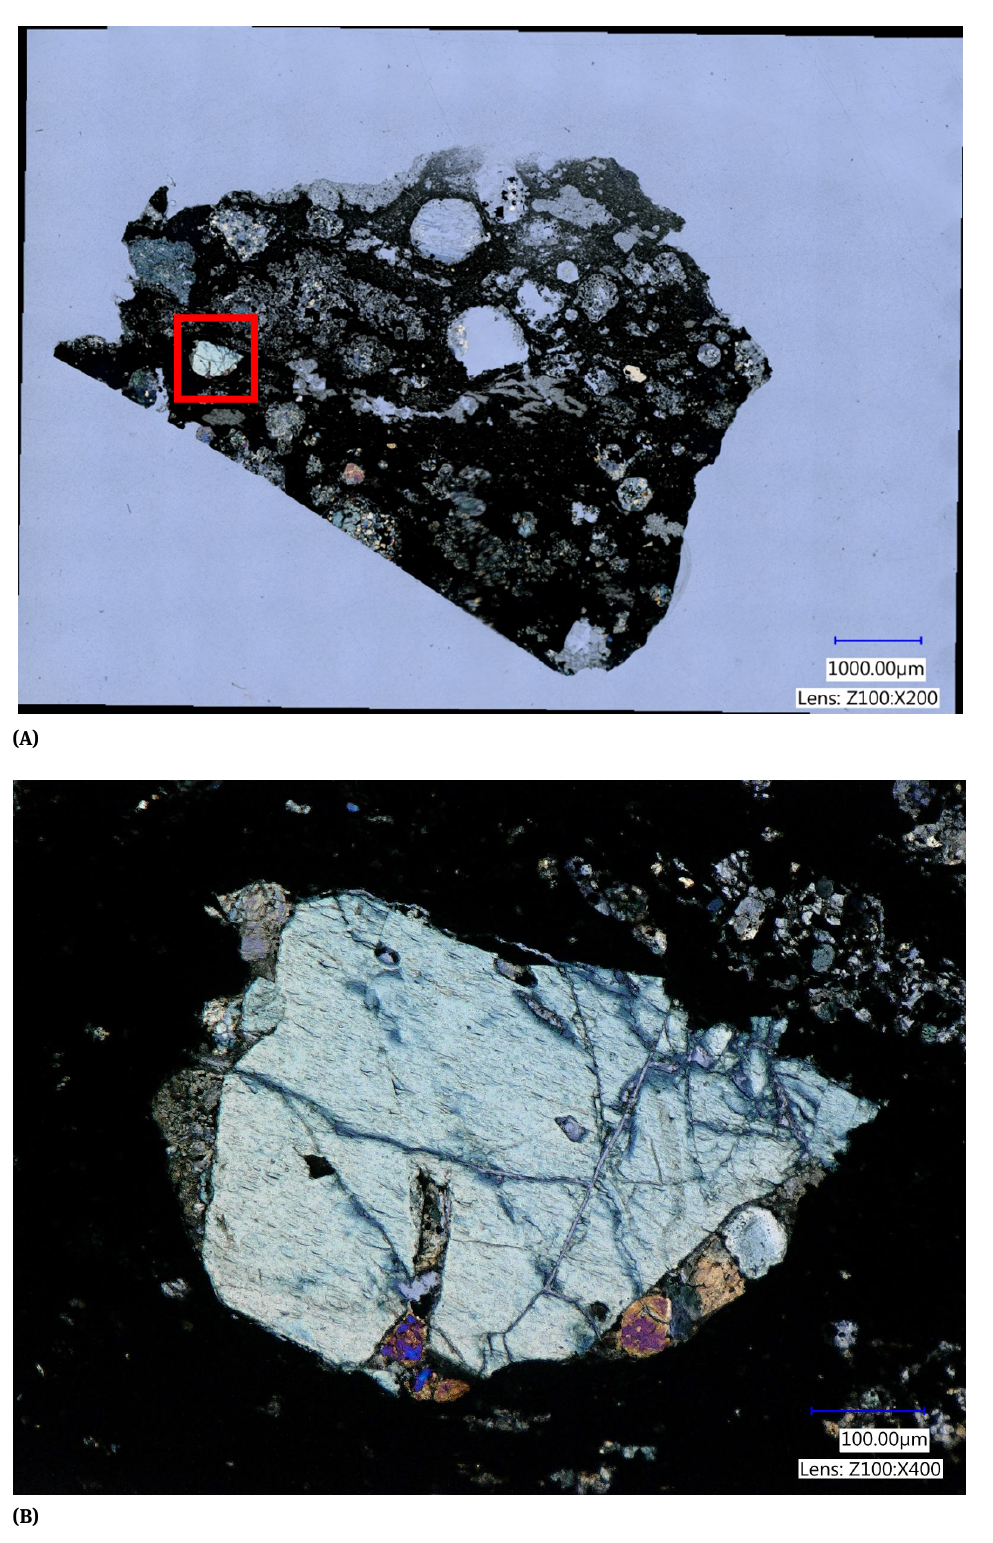
Figure 1. A transmitted optical microscope image shows the Kaba meteorite thin section (A). The selected olivine grain is distinguished by a red a square. Cross-poarized picture of an olivine grain exhibits homogeneous and well-crystalline structure